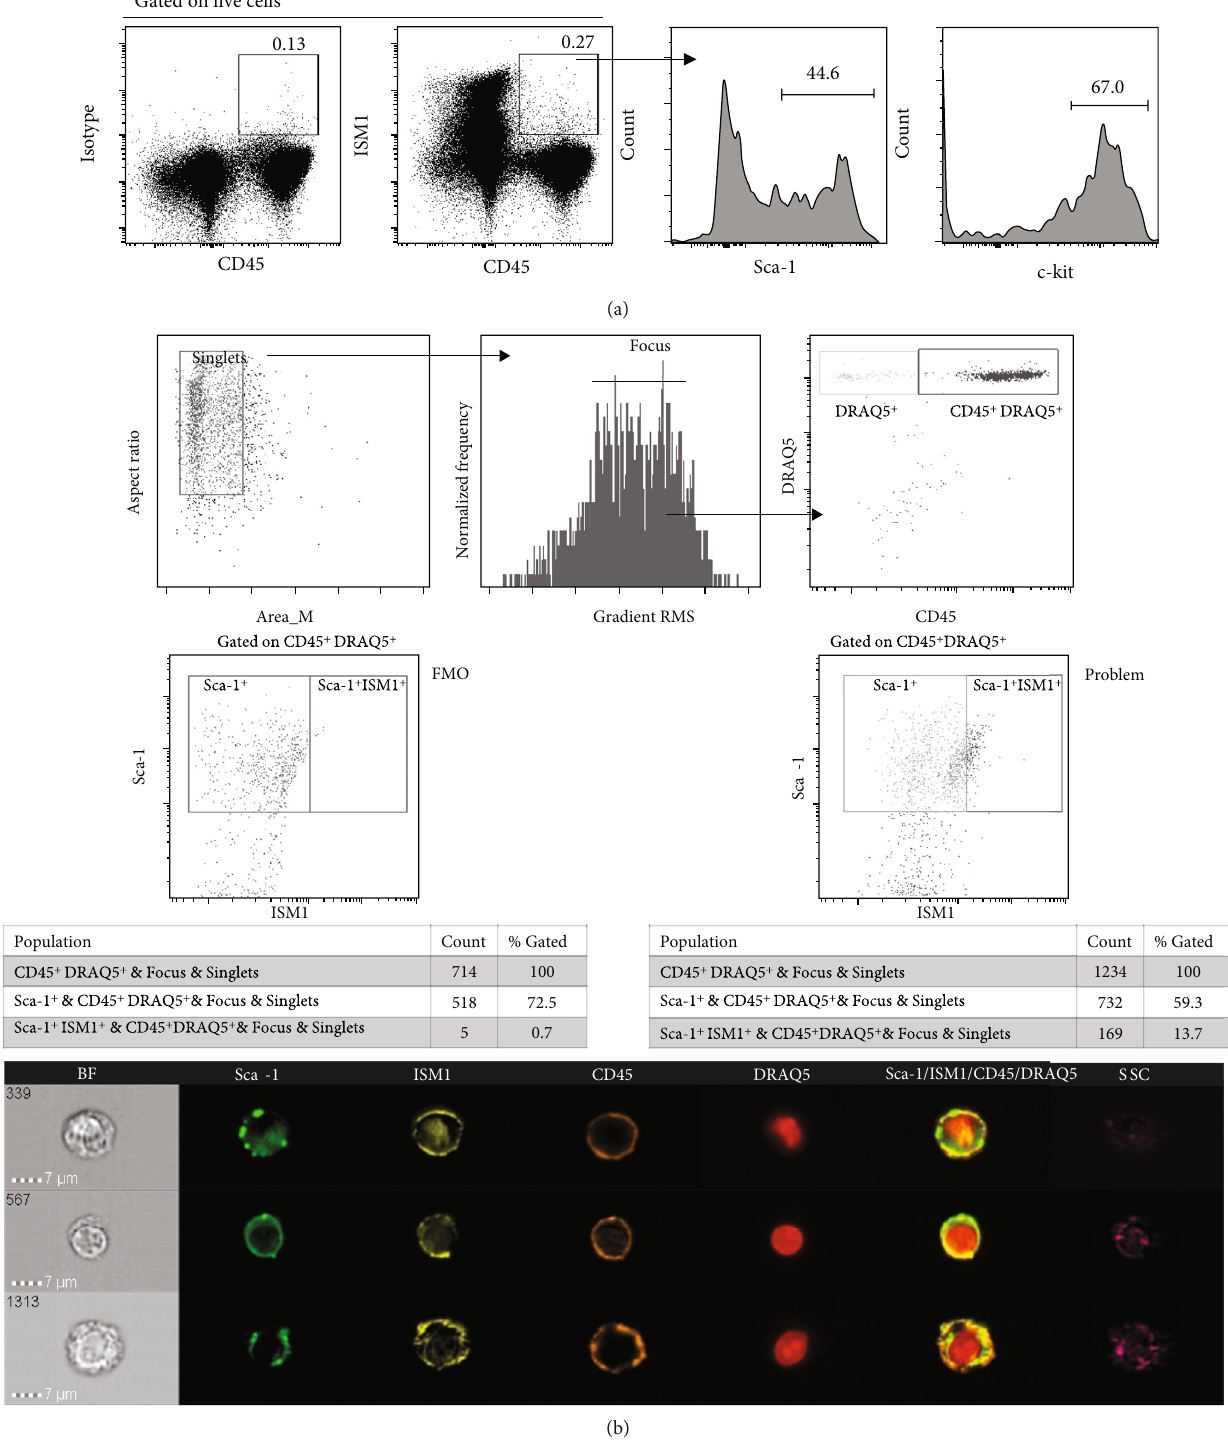
Figure 4: ISM1 + cells include hematopoietic progenitor stem cells. (a) Lung-derived ISM1 + CD45 + cells were selected and analyzed for Sca-1 and c-kit coexpression. (b) ImageStream analysis of Sca-1 + CD45 + ISM1 + lung cells. For (a) and (b), a representative experiment (out of 3) is shown. FMO: fl uorescence minus one